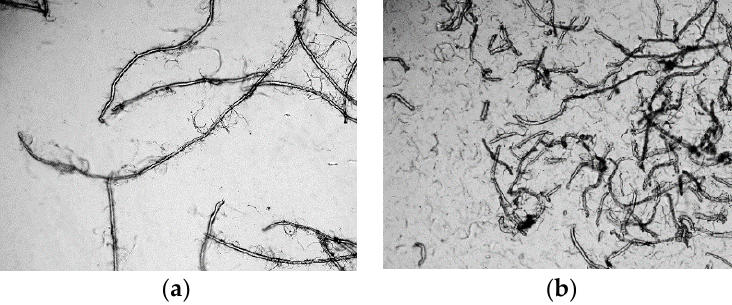
Figure 2. Microscopic images (×100) of fibrillated the Lyocell fiber under refining pressure of 3.33 N/mm: ( a ) 10,000 revolutions; ( b ) 40,000 revolutions.